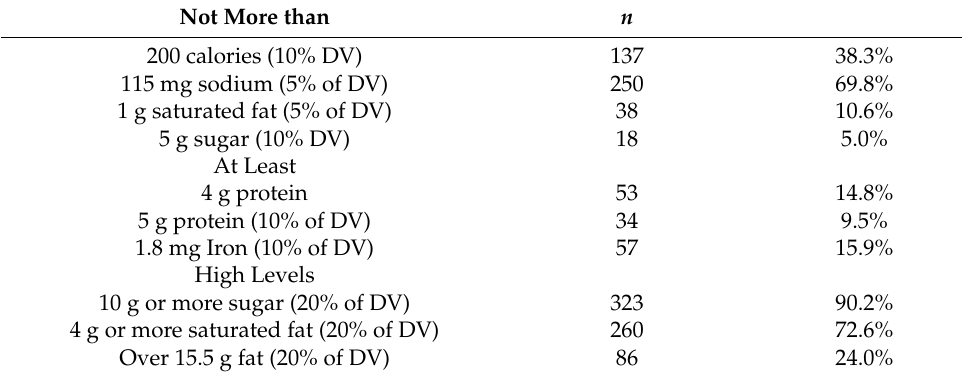
Table 2. Percentage of 358 non-dairy frozen desserts as pints meeting or exceeding suggested guideline/serving.